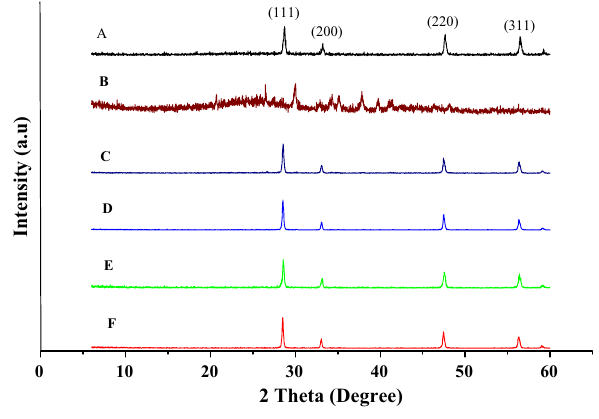
Fig. 3 Powder X-ray patterns of CeO